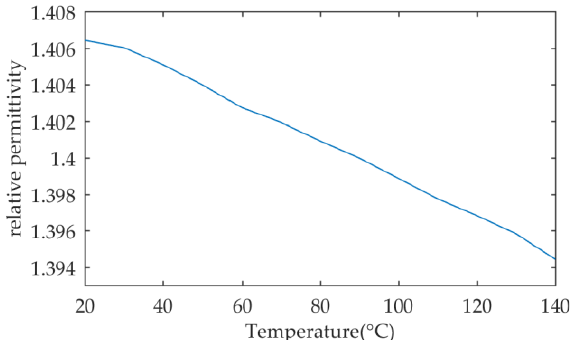
Figure 3. Temperature-dependent curve of the relative permittivity of ePTFE at 1 GHz.